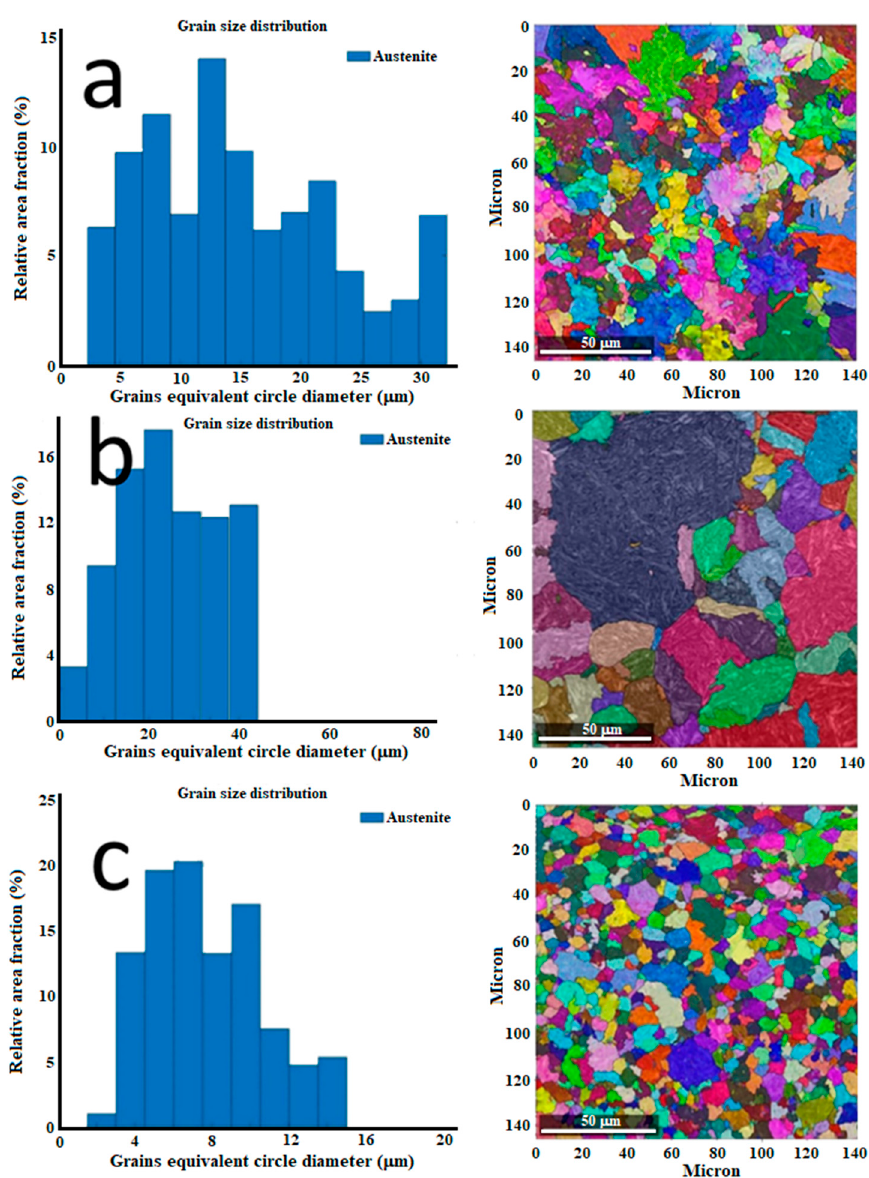
Figure 10. EBSD images of the PAG distribution of ( a ) 1.6511Si2, ( b ) 1.6511Si2V, and ( c ) 1.6511Si2M. By adding vanadium to the chemical composition the PAG size increased and by adding a rare earth element it decreased.